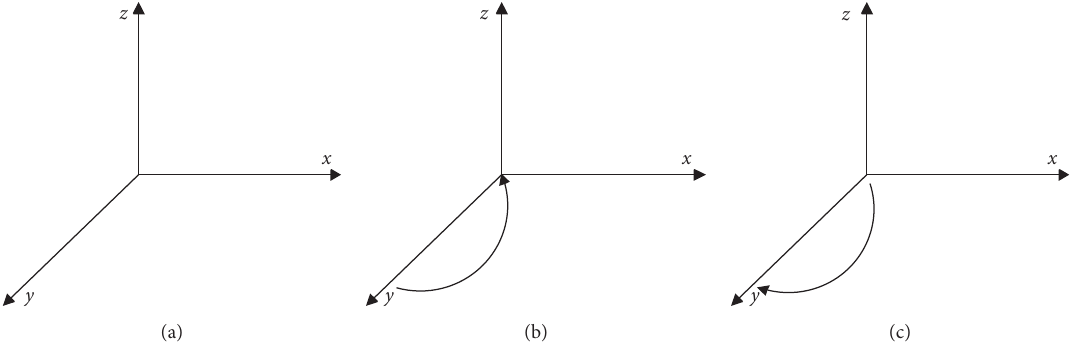
Figure 3: Dynamic phase diagram of new media strategy selection stability evolution and replication.